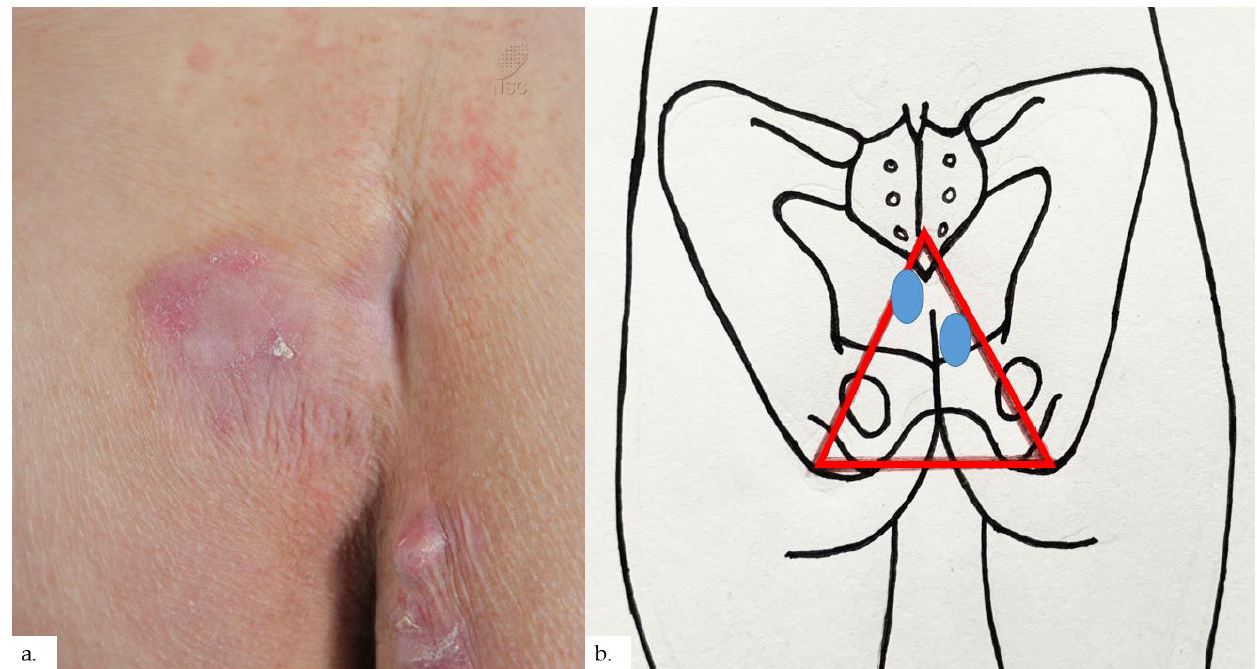
Figure 3. Patient 2. ( a ) There were bilateral erythematous plaques over his buttocks, with scaling and lichenification; notably, there was blancheable erythema over the natal cleft; ( b ) the plaques (blue ovals) were slightly asymmetrical, with the one on the left just lateral to the coccygeal apex, whilst the one on the right was located more inferior-medially at the intergluteal fold, within the upper portion of the sitter’s triangle (red triangle).